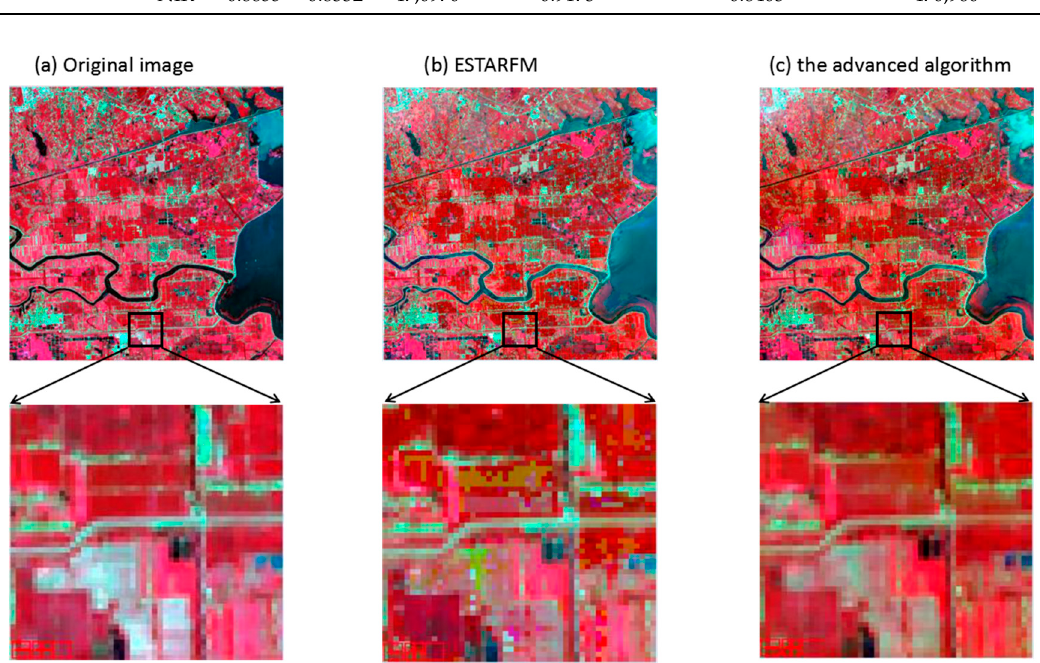
Figure 7. ( a ) Part of the actual image observed on 23 July 2016 and ( b ) its corresponding prediction images by ESTARFM and ( c ) the modified algorithm using phenological information. The lower rows are amplified scenes of the area marked in the upper rows.